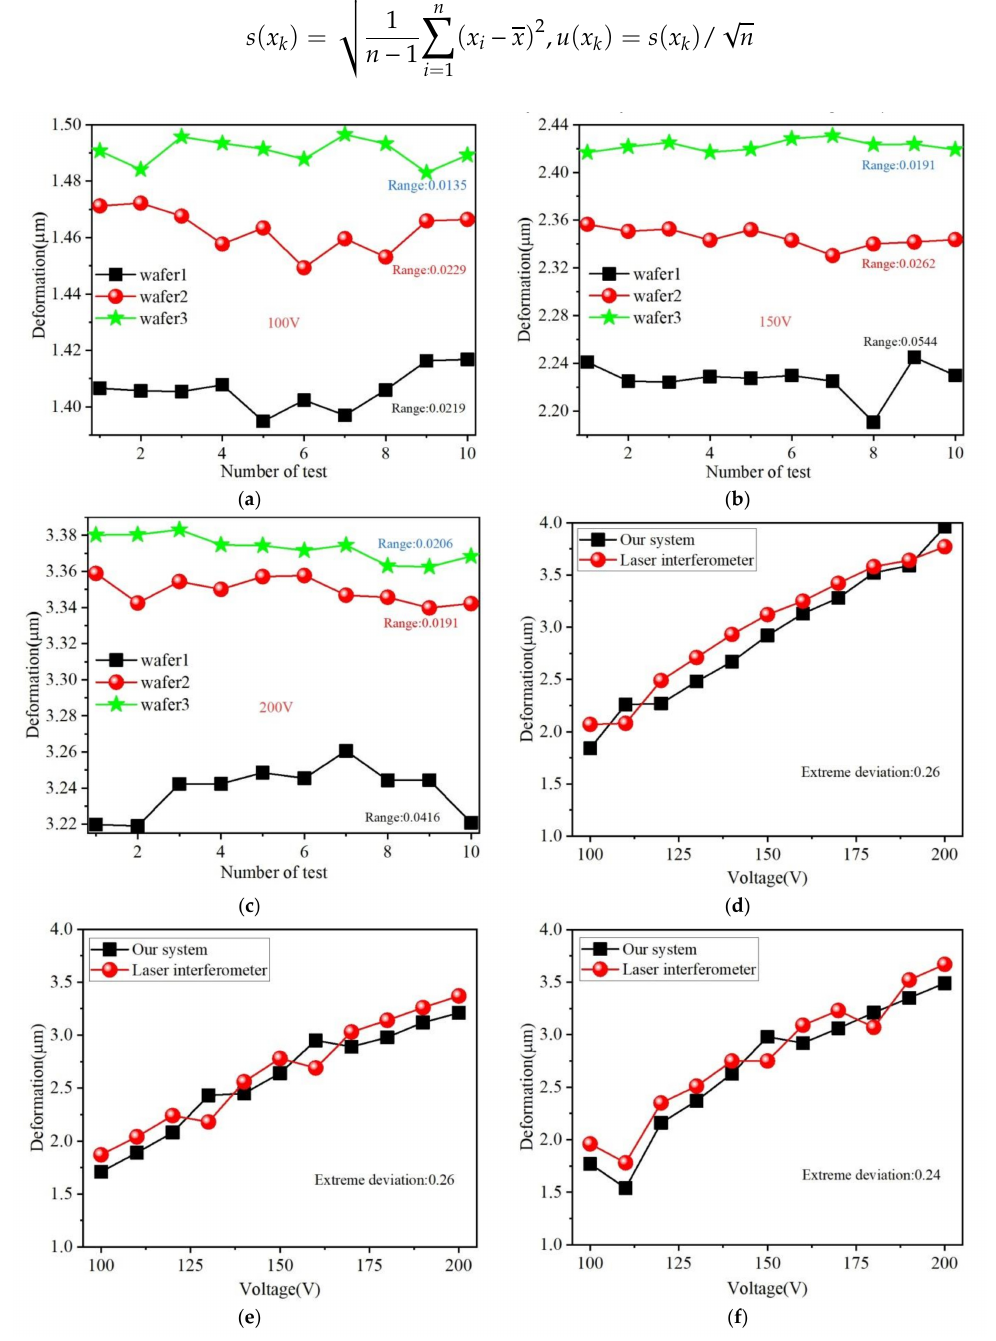
Figure 12. Measurement results of the three arbitrary annular / rectangular wafers at specific voltages of ( a ) 100 V for annular test sample 1, ( b ) 150 V for annular test sample 2, ( c ) 200 V for annular test sample 1, ( d ) 100 V~200 V for rectangular test sample 1, ( e ) 100 V~200 V for rectangular test sample 2, and ( f ) 100 V~200 V for rectangular test sample